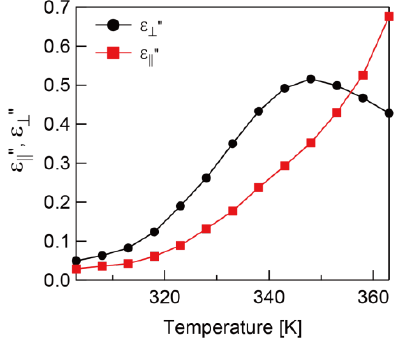
Figure 6. Temperature-dependent imaginary parts of the complex dielectric constants of the polymerized sample at 3